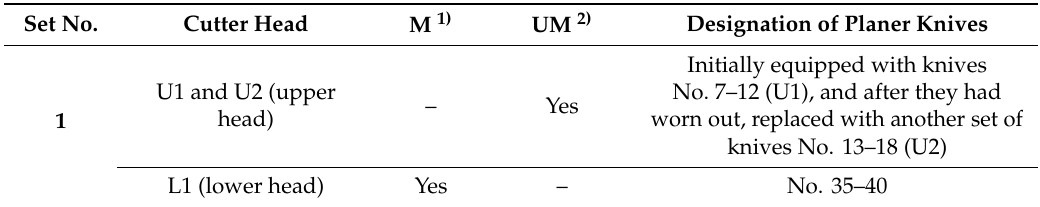
Table 2. Characteristic of industrial planer knives used in the experiments. Set No.